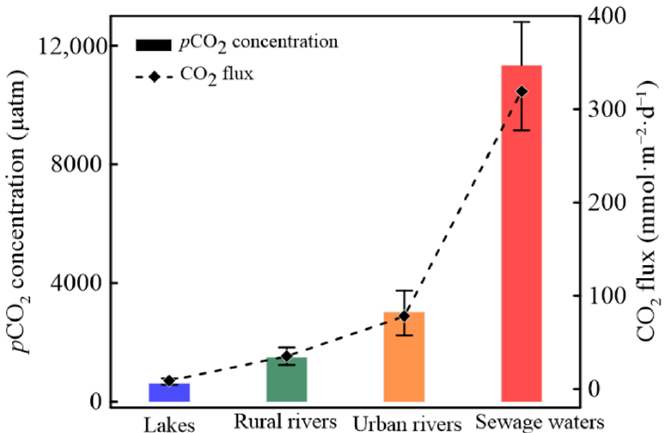
Figure 5. The relationship of p CO 2 concentration and CO 2 fluxes in river waters in Tianjin.